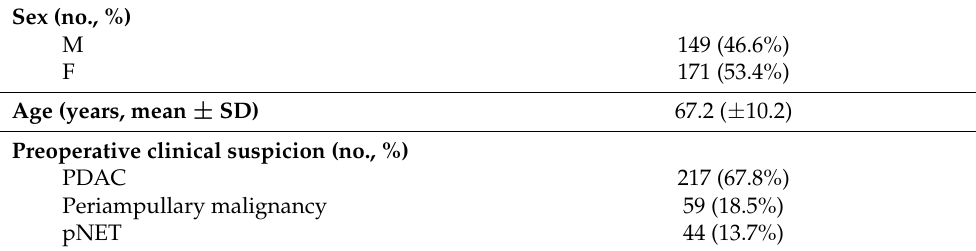
Table 1. General features and clinical suspicion ( n =